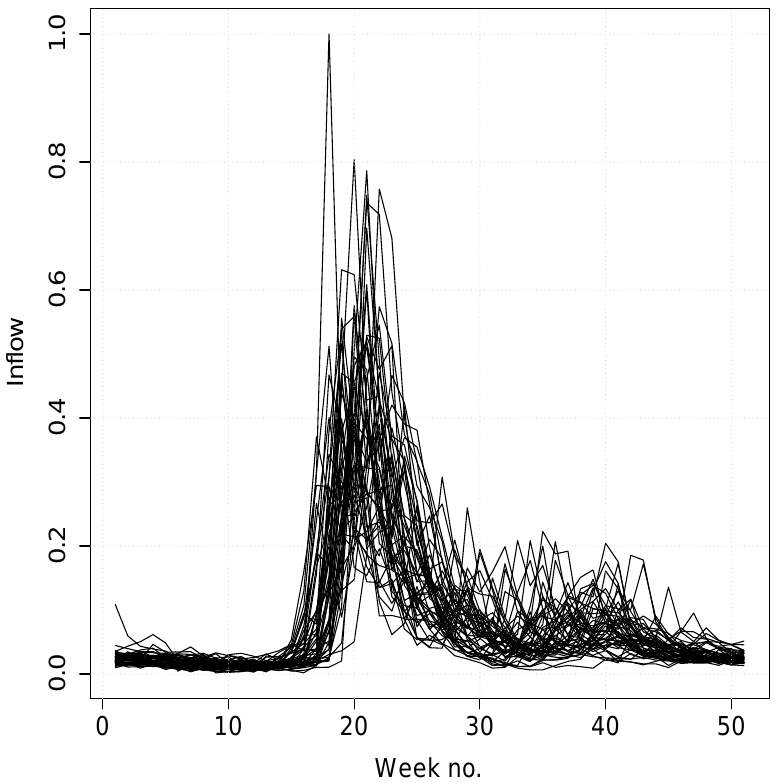
Figure 3. Historical inflow data used for fitting the stochastic inflow model. Values are in fractions of the maximum inflow value.